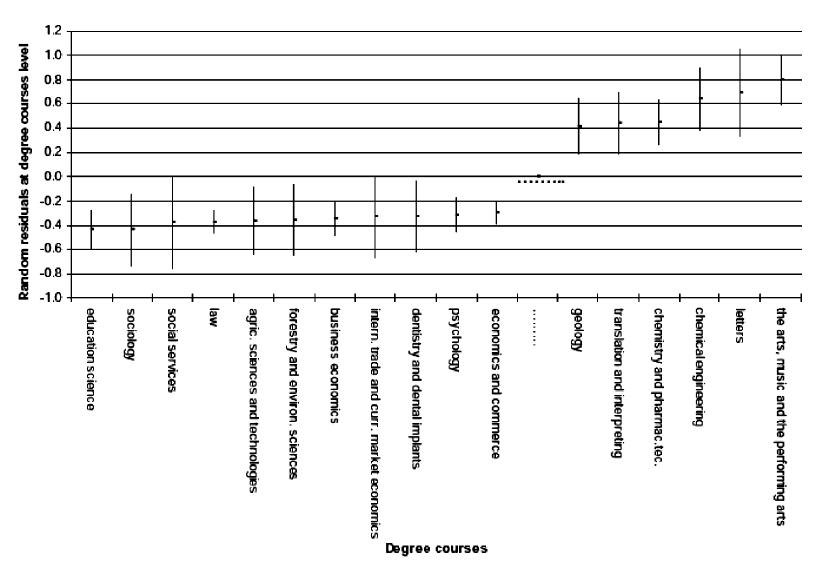
Figure 3 – Ranking of (extreme) degree courses as a function of third-level